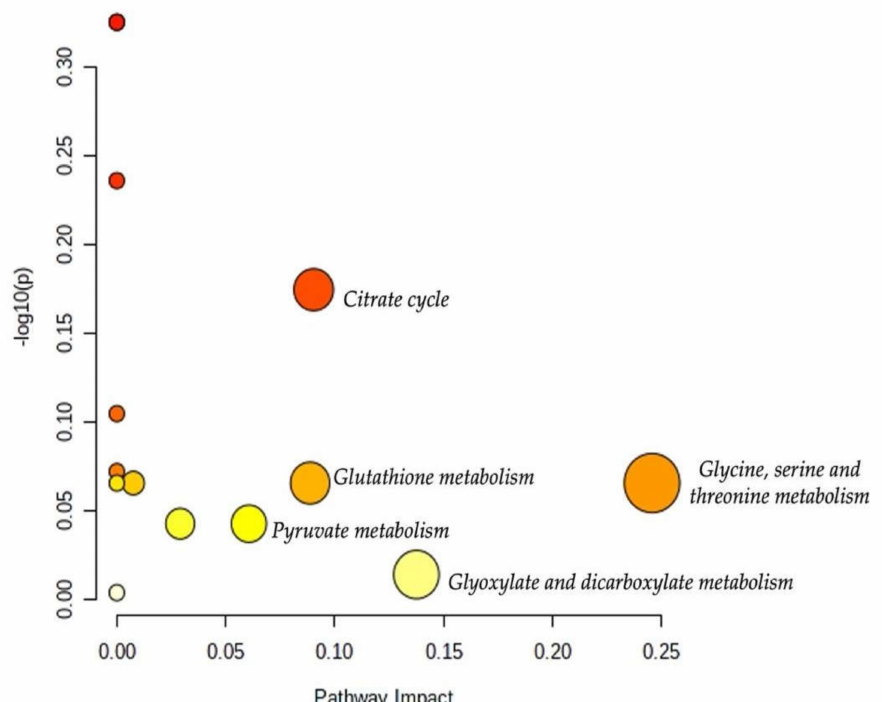
Figure 10. Overview of the pathway analysis arranged according to the scores from the enrichment analysis (y-axis) and the topology analysis (x-axis). The color and size of each circle (pathways) are based on its p -value and pathway impact value, respectively. Circles located in the top right diagonal region represent pathways with significant metabolite changes and higher impact. The pathway names with the highest impact values (largest circles) are mentioned (glycine, serine, and threonine metabolism; glyoxylate and dicarboxylate metabolism; citrate cycle; glutathione metabolism; pyruvate